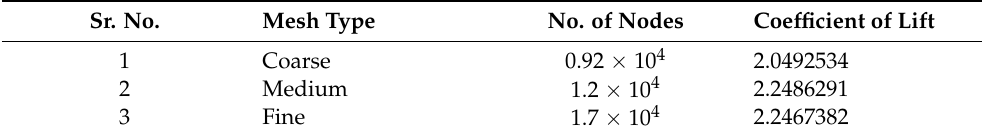
Figure 4. Case I—3D representation of a single-row landscape configuration.